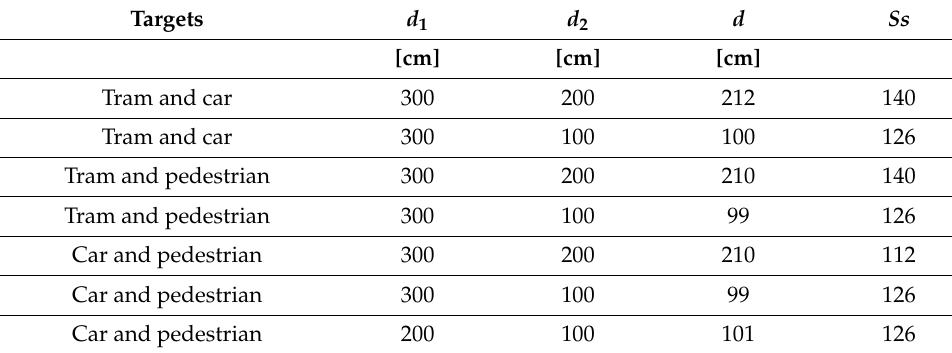
Table 8. Different objects in the sensor field of view experimental